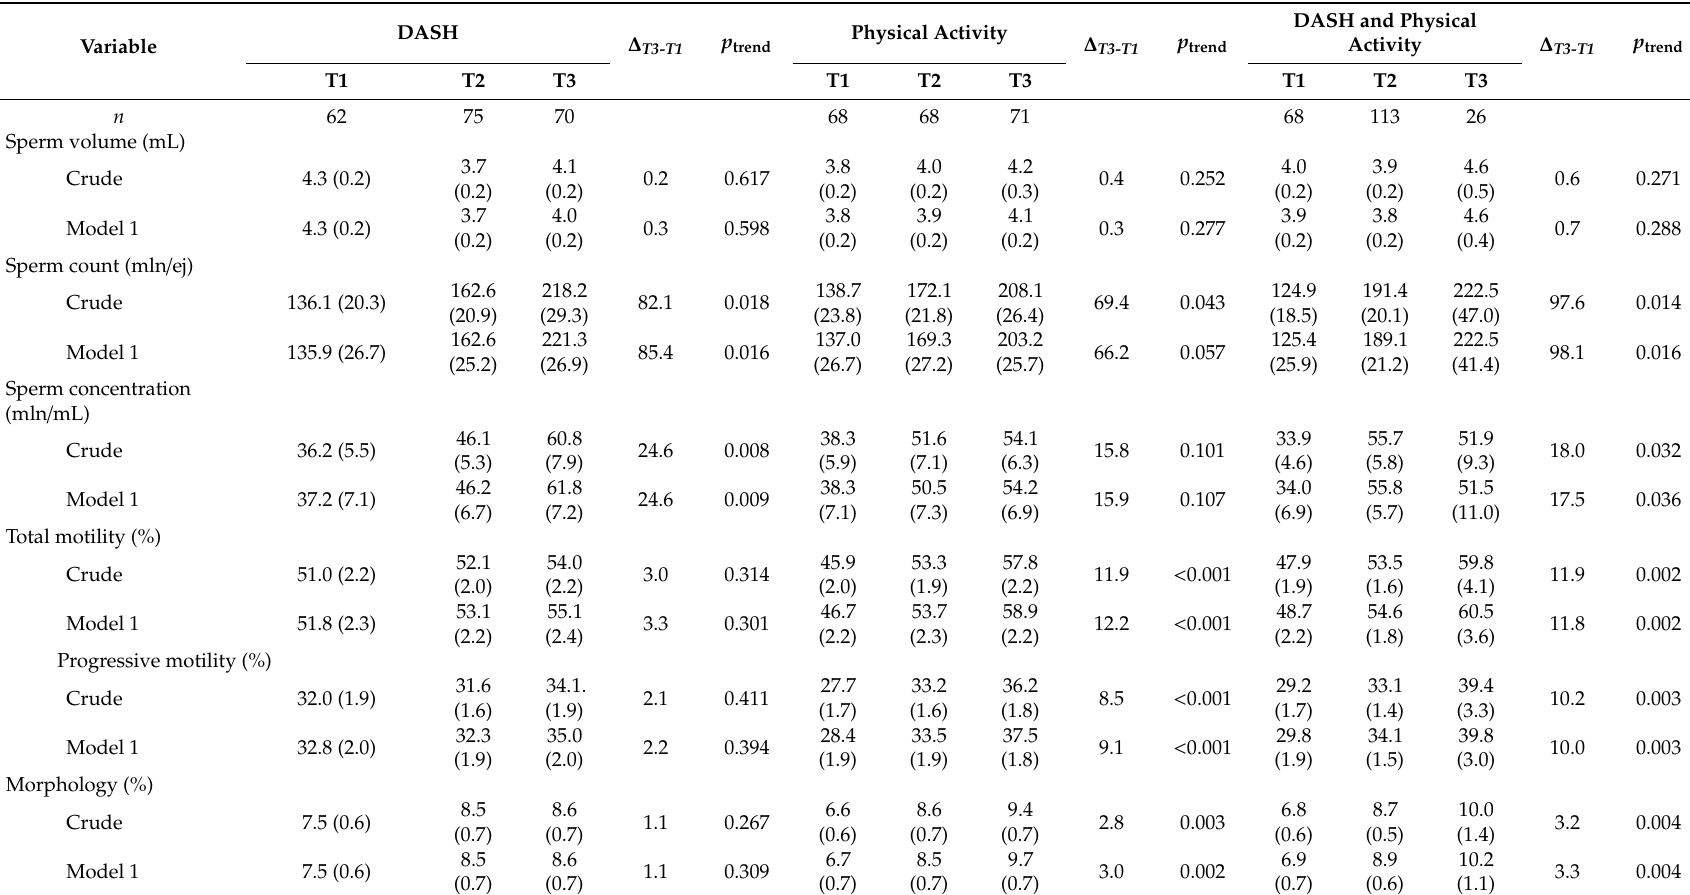
Table 2. DASH, physical activity, and their combination in relation to semen